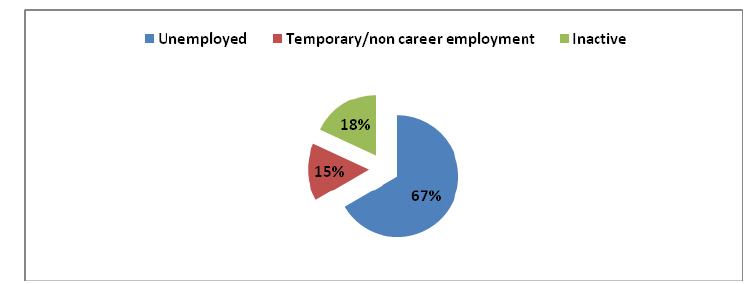
Figure 3: In-transition youth by current activity